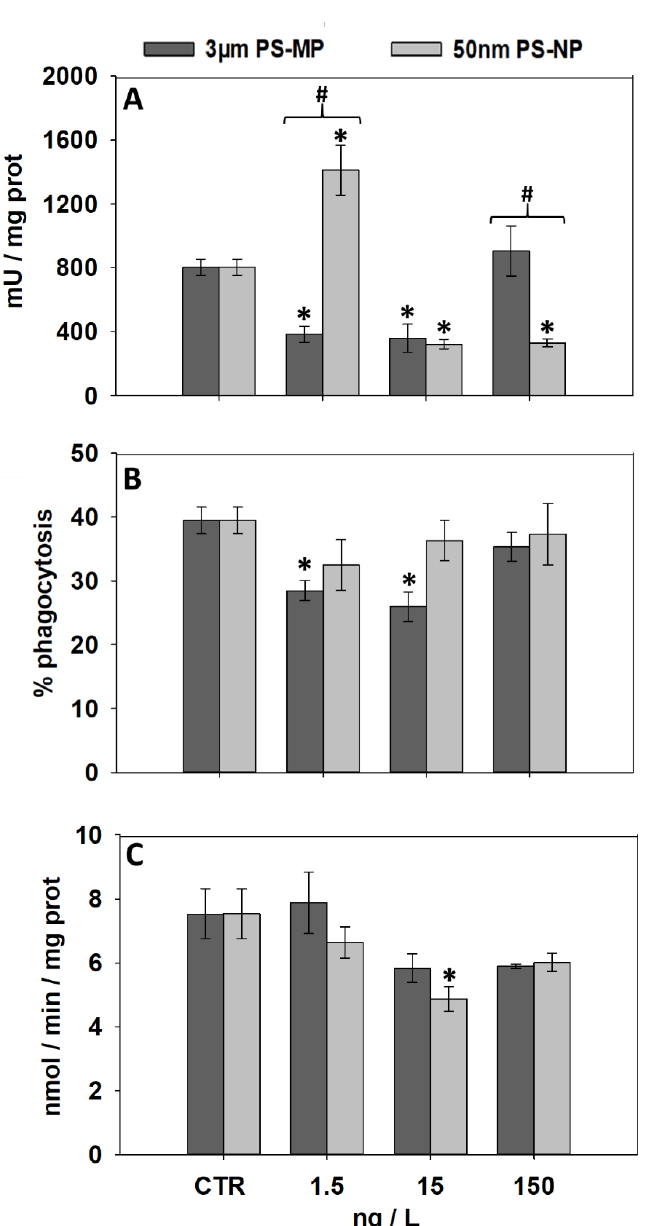
Figure 4. Immunological and neurological parameters (mean ± SEM, N = 3) analyzed in mussels after 21 days of exposure to PS-MP and PS-NP; ( A ), lysozyme activity (LSZ) in the hemolymph serum; ( B ), hemocytes phagocytic activity; ( C ), acetylcholinesterase (AChE) activity in gills. *, significant ( p < 0.05) differences compared to control samples (CTR); #, significant differences ( p < 0.05) between PS-MP and PS-NP treatments.